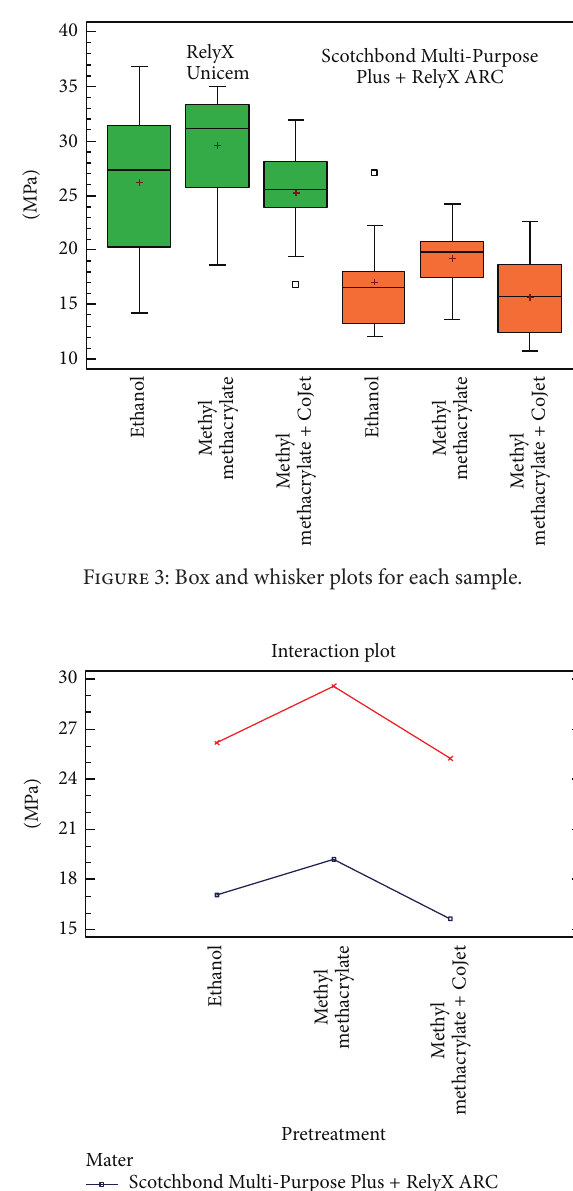
Figure 4: Plot of interaction effect between pretreatment and ce- ment